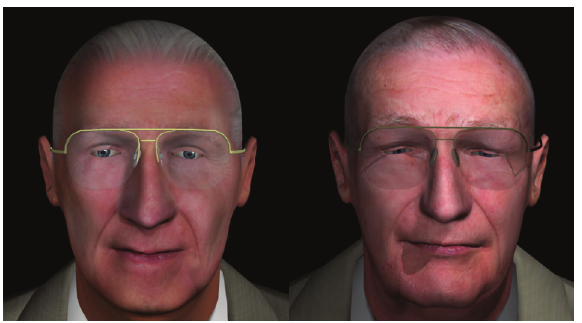
Figure 8. Comparison of FaceGen Diffuse Map (Left) vs. our Custom Map (Right) When Applied to the Avatar